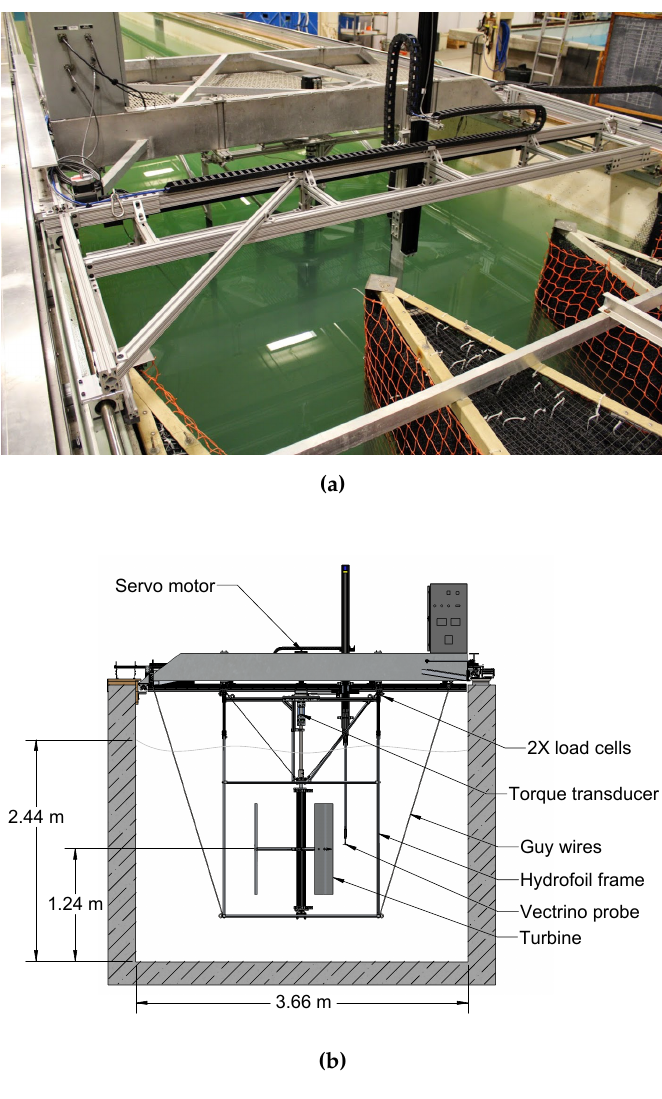
Figure 2. Experimental setup photo ( a ) and drawing ( b ): turbine test bed installed in the UNH tow